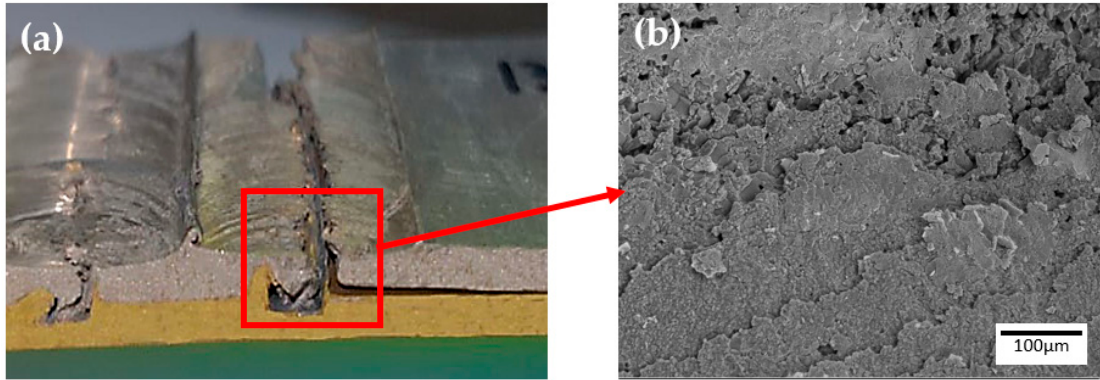
Figure 16. Fracture of the cladded Al–Cu of sample No. 26; ( a ) failure position and ( b ) SEM image of the fracture surface.